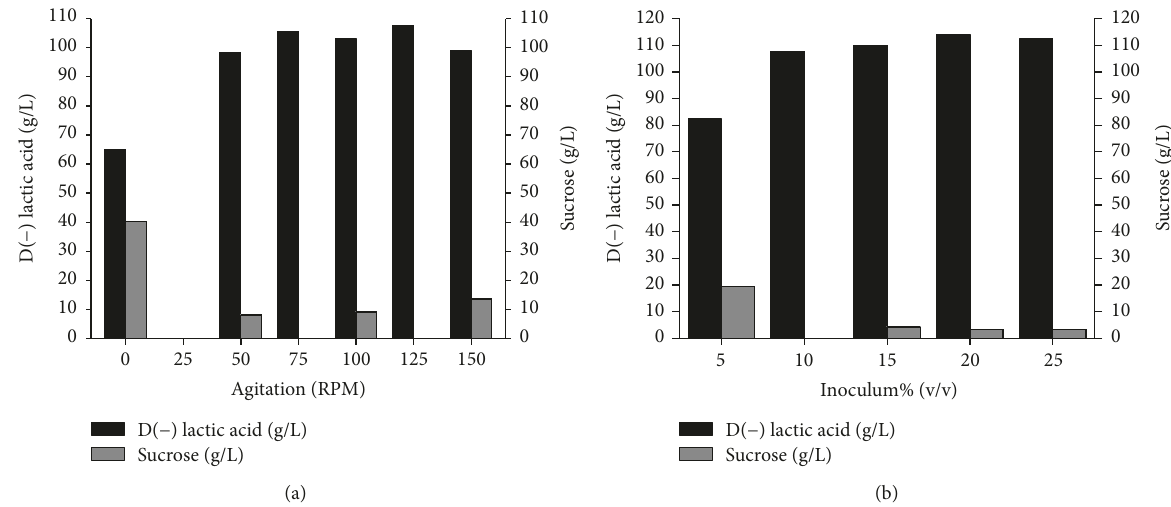
Figure 4: Effect of (a) agitation and (b) inoculum size on D( − ) lactic acid production and sucrose consumption by S. nakayamae . Culture conditions: GYP modified medium (120 g/L crystallized sugar, 35 g/L yeast extract, and 7.5mL/L salt solution) with NaOH 10 N as pH neutralizing agent. (a) GYP modified medium at 35 ∘ C, pH 6.0, with 10% inoculum; (b) GYP modified medium at 35 ∘ C and pH 6.0 under 125